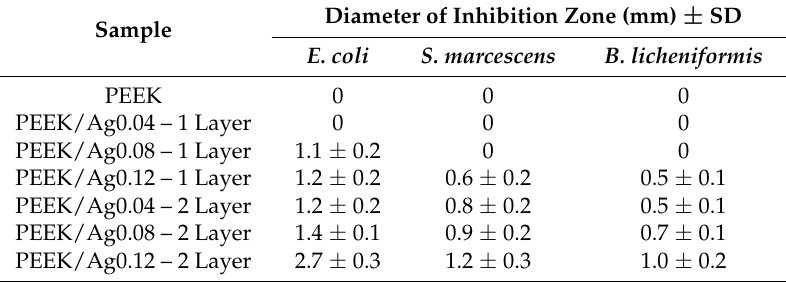
Table 3. Antibacterial activity of silver nanoparticles deposited in PEEK